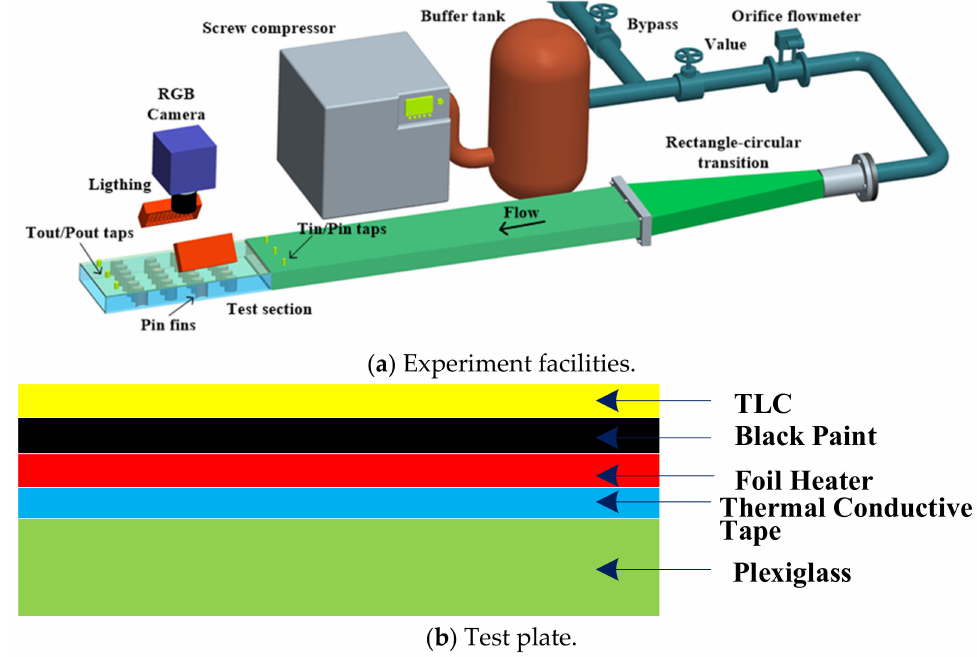
Figure 1. Sketch of heat transfer experimental